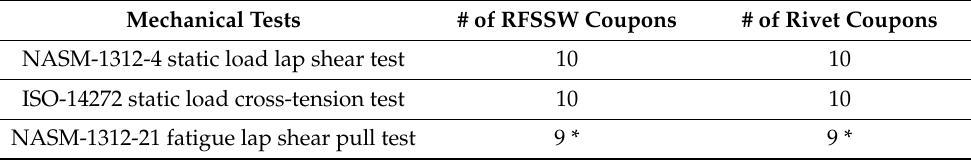
Table 1. Coupon Table 1. Coupon quantities.